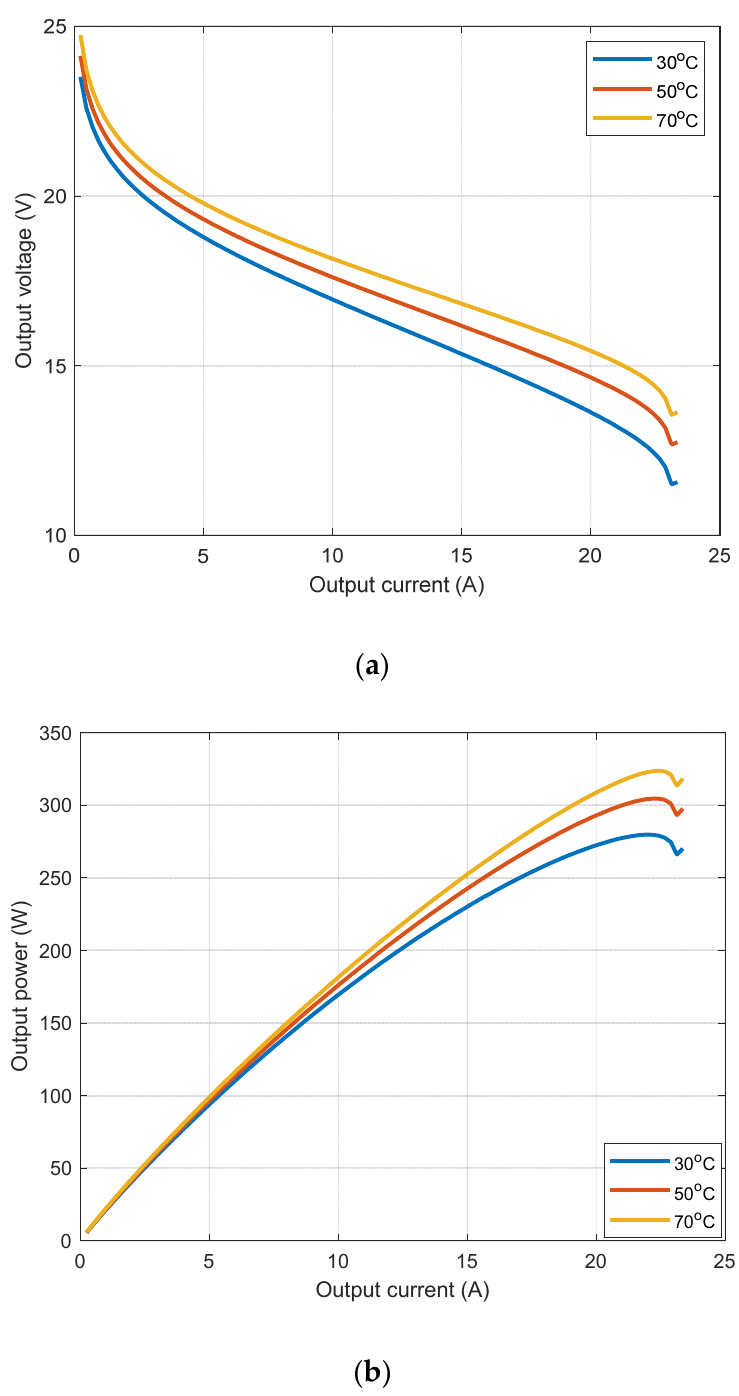
Figure 15. Characteristics of 250 W stack under various temperatures: ( a ) current-voltage and ( b ) current-power.